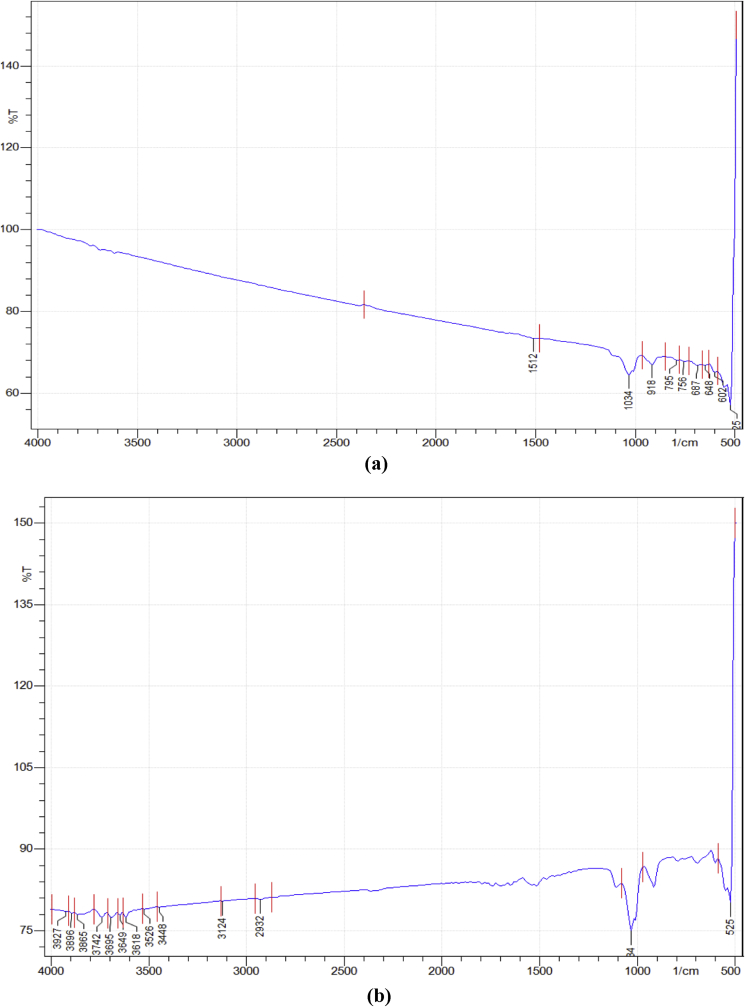
FT-IR result for (a) raw (b) HCl activation Aloji clay.